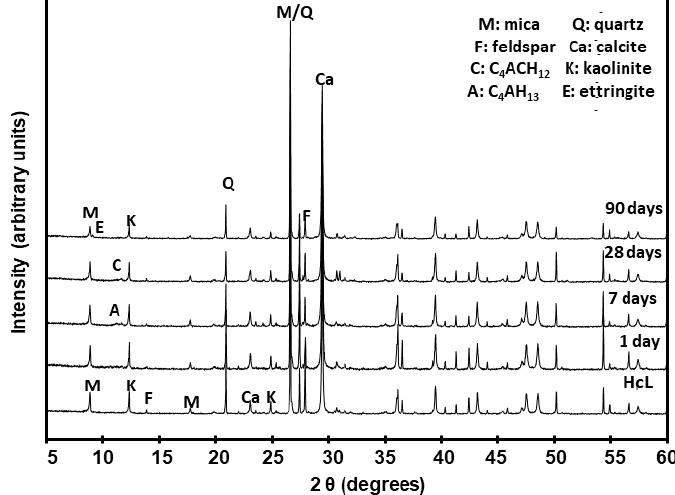
Figure 13. XRD patterns for initial waste HcL and after reaction with lime. Table 6. Rietveld refinement for six types of fine particle CDW (M: mica, Q: quartz; F: feldspar, C: calcite; Ett: ettringite; Am. Mat.: amorphous material; K: kaolinite; n.d.: not detected; t: traces; X 2 : Rietveld goodness of fit; R B : Bragg R